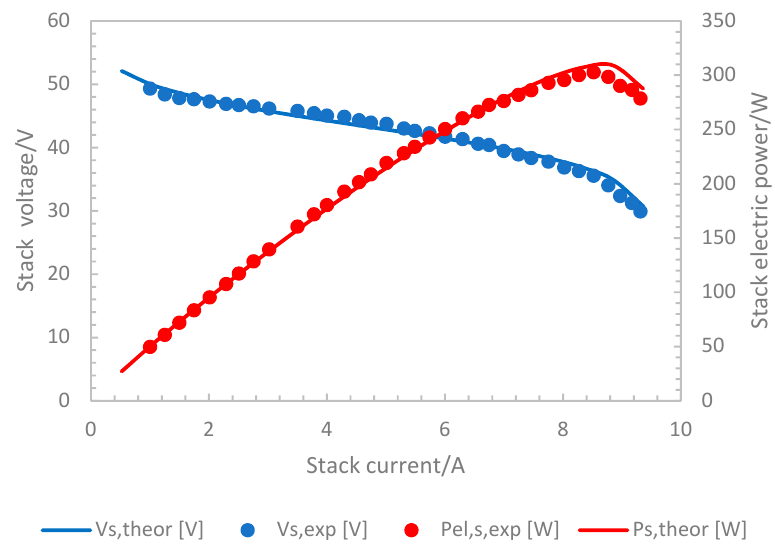
6 of 22 Table 1. Main PEM stack technical data. Technical Parameter